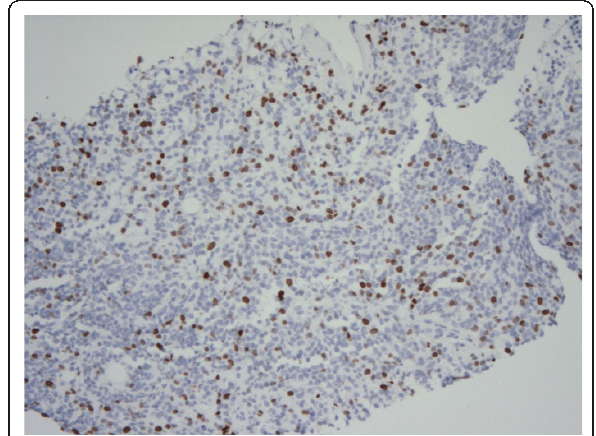
Figure 6 Microphotograph demonstrating positive Ki-67 staining in nearly 35% of tumour cells . [MIB-1 stain, 100